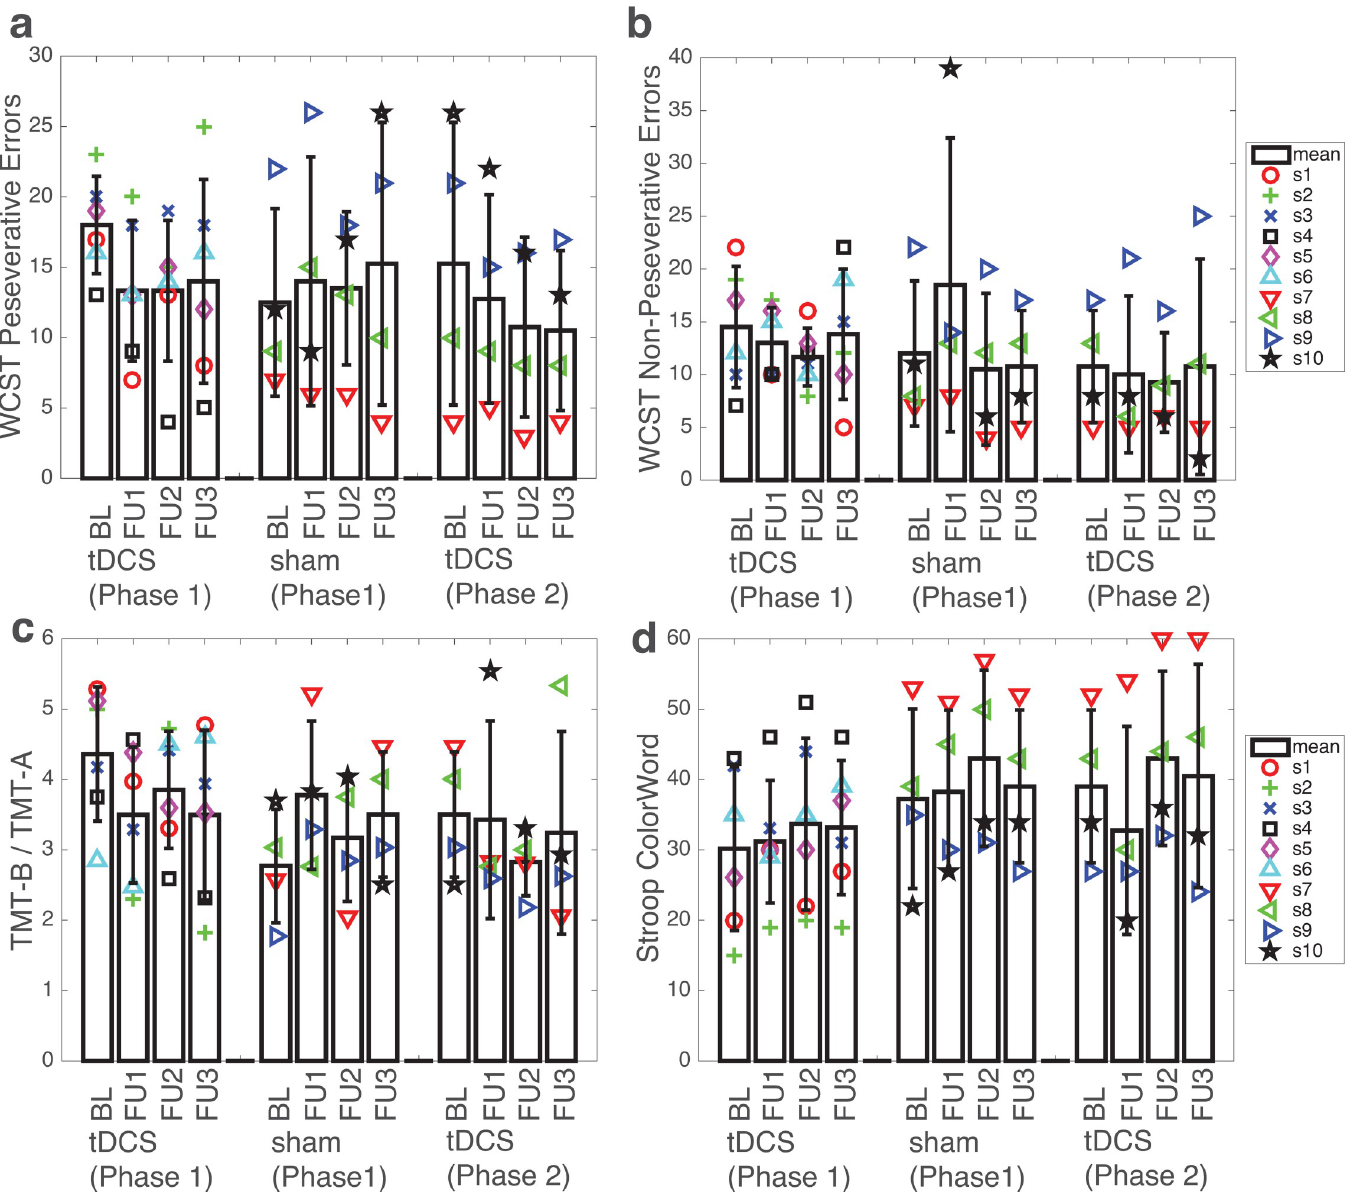
Fig 2. Neuropsychology test scores. (a) Wisconsin Card Sorting Test (WCST) Perseverative Errors. (b) WCST Non-Perseverative Errors. (c) The ratio of Trail Making Test B (TMT-B) to Trail Making Test A (TMT-A). (d) Stroop Color and Word Test (SCWT) color-word. Left: tDCS (1st phase)–participants who received cingulate tDCS treatment during Phase 1; middle: sham (1st phase)–participants who received sham tDCS treatment during Phase 1; right: tDCS (2nd phase)–participants who received cingulate tDCS treatment during Phase 2. BL, baseline visit (prior to the first treatment sessions); FU1/FU2/FU3, follow-up visit 1, 2, 3 after the last treatment session, respectively. For participants who received sham tDCS during Phase 1, data from FU3 of Phase 1 were used as BL for Phase 2. Markers represent individual participants. Bars represent group average at each study phase. Error bars represent standard deviation. See Supplementary Materials for the complete test scores of all neuropsychology